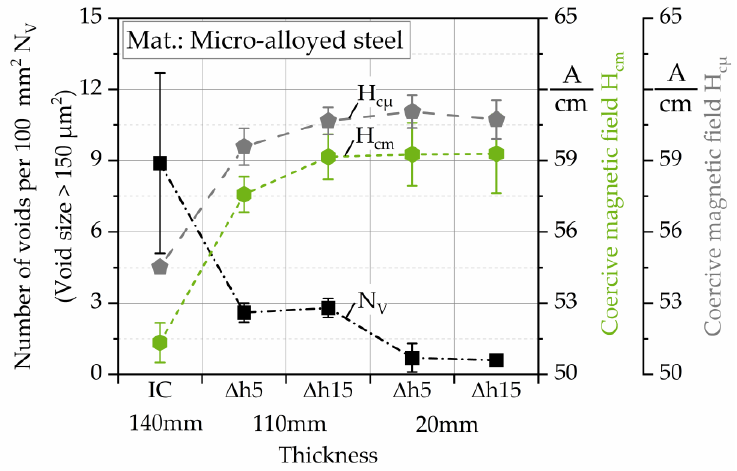
Figure 6. Coercive magnetic field by Barkhausen noise (H cm ) and by incremental permeability (H c µ ), correlated with the number of voids > 150 µ m 2 per 100 mm 2 (N V ) of hot flat rolled microalloyed mild steel. Number of voids from [6].